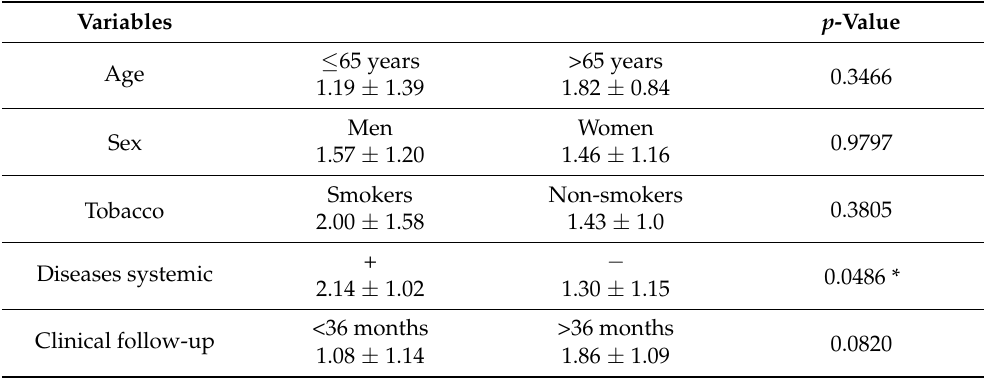
Table 6. Marginal bone loss (1.51 ±